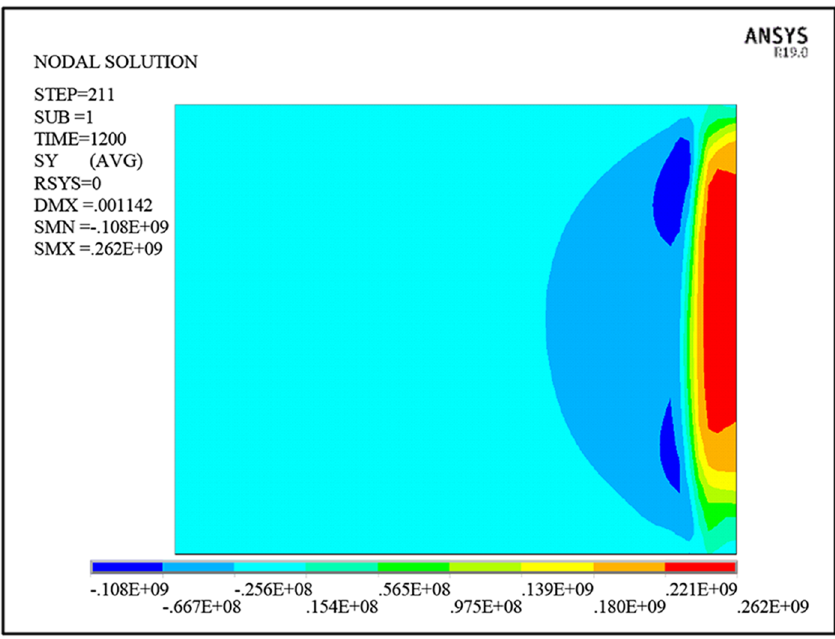
Fig. 6. Welding-induced longitudinal stress (Unit: MPa).